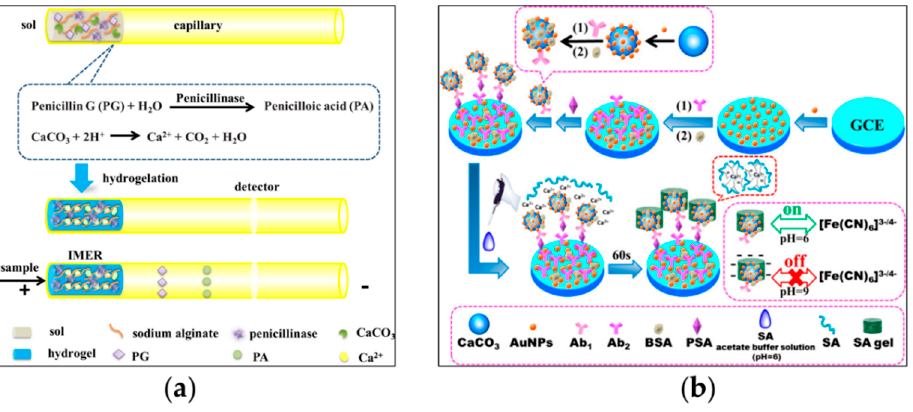
Figure 2. Schematic illustrations of the principle of polysaccharide hydrogel sensors. ( a ) The on-line enzyme assays for penicillinase utilizing CE-IMERs; ( b ) The cascaded signal amplification sandwich-type impedimetric immunosensor based on sodium alginate hydrogels’ precipitation for prostate specific antigen (PSA) detection. Reproduced with permission from Xiaotong Hu ( a ) and Lihua Zhao ( b ), Talanta ( a ) and ACS Sensors ( b ); published by Elsevier ( a ) and American Chemical Society ( b ), 2018 ( a ) and 2019 ( b ).